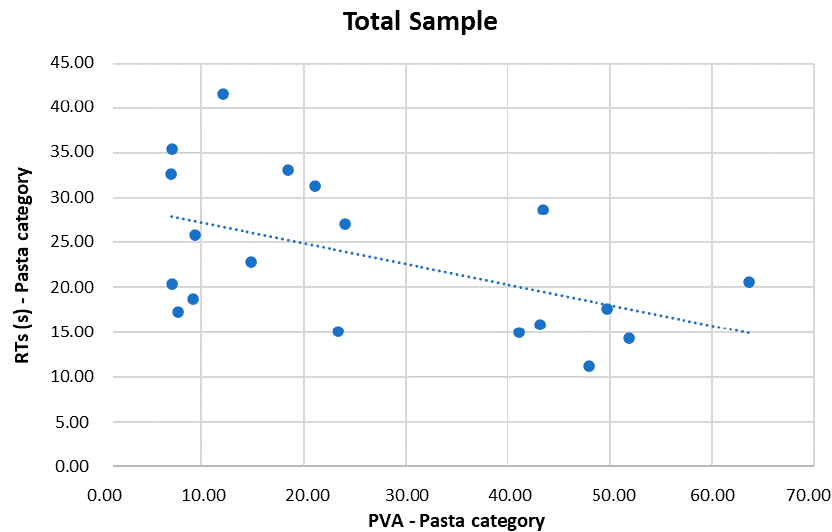
Figure 3. Correlation result: PVA and behavioural data. Significant negative correlation between and PVA values for the entire group in pasta RTs and PVA values for the entire group in pasta category.